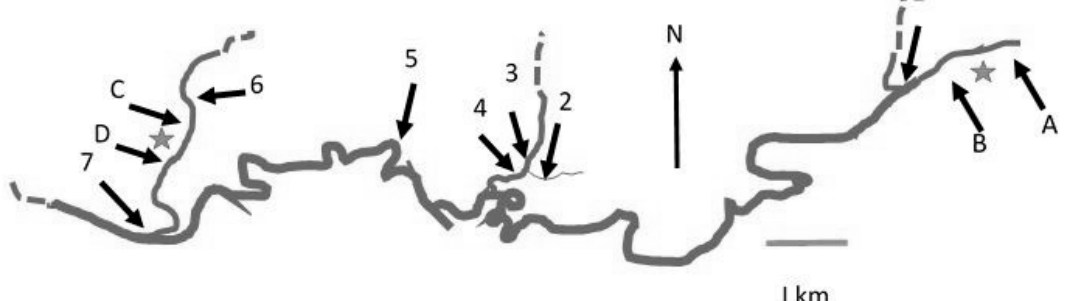
Figure 1. Sampling sites on the rivers Tywi, Cothi and Dulas (Sites 5, 6 and 7 represent weekly sample points; Monthly samples comprised Tywi upstream of Waste water treatment Works (WWTW *) ( A ); Tywi downstream of WWTW * ( B ); Cothi upstream of WWTW ( C ); Cothi downstream of WWTW * ( D ); Sites 1, 2, 3, 4, 6 and 7 represent sites sampled on the same day as the fine sampling site, (5) sites which were sampled on three occasions every 30 min, and the remaining sites were sampled once on each occasion).